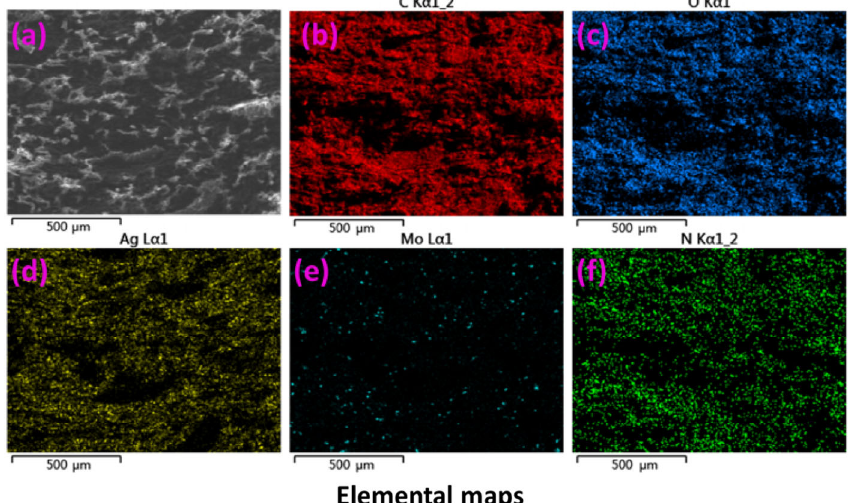
Fig. 2 (a) SEM micrographs of TPI-1 cross-section and its EDS maps of elements: (b) C, (c) O, (d) Ag, (e) Mo, and (f) N for